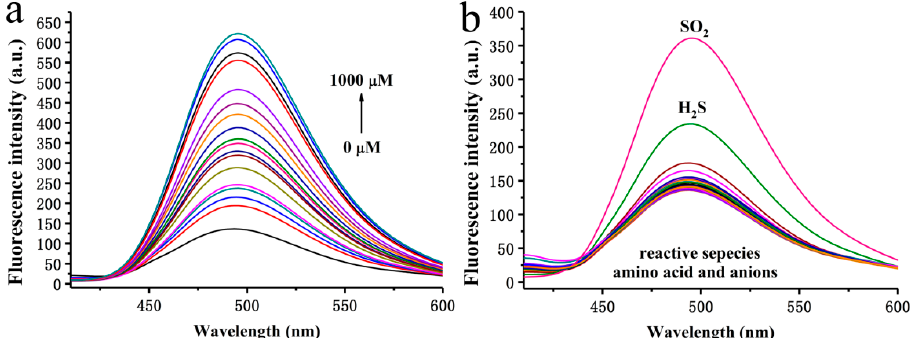
Figure 4. Fluorescence responses of BPO-DNP to SO 2 . ( a ) Fluorescence responses of BPO-DNP (10 μ M) to different concentrations of SO 2 (0–1000 μ M). ( b ) Fluorescence response of BPO-DNP (10 μ M) with 500 μ M of different kinds of amino acids (Arg, Met, Ser, Asp, Gly, Ala, His, Val, Lys, Leu, Glu, Pro, Ile, Phe), reactive species, and anions (H 2 O 2 , NaClO, TBHP, NO 3 − , NO 2 − , SO 42 − , Cys, Hcy, GSH, H 2 S, SO 2 ) in 10 mM pH 8.0 phosphated-buffered saline (PBS) and dimethylsulfoxide (DMSO) mixture solution (8:2, v / v ), λ ex = 556 nm. Slit: 10 nm/10 nm.